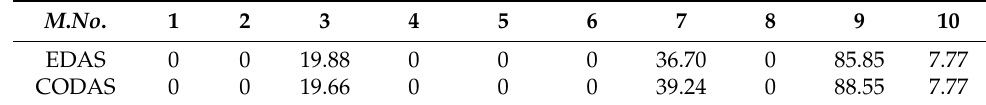
Table 14. Machine engagement time ( met ) of individual machine.